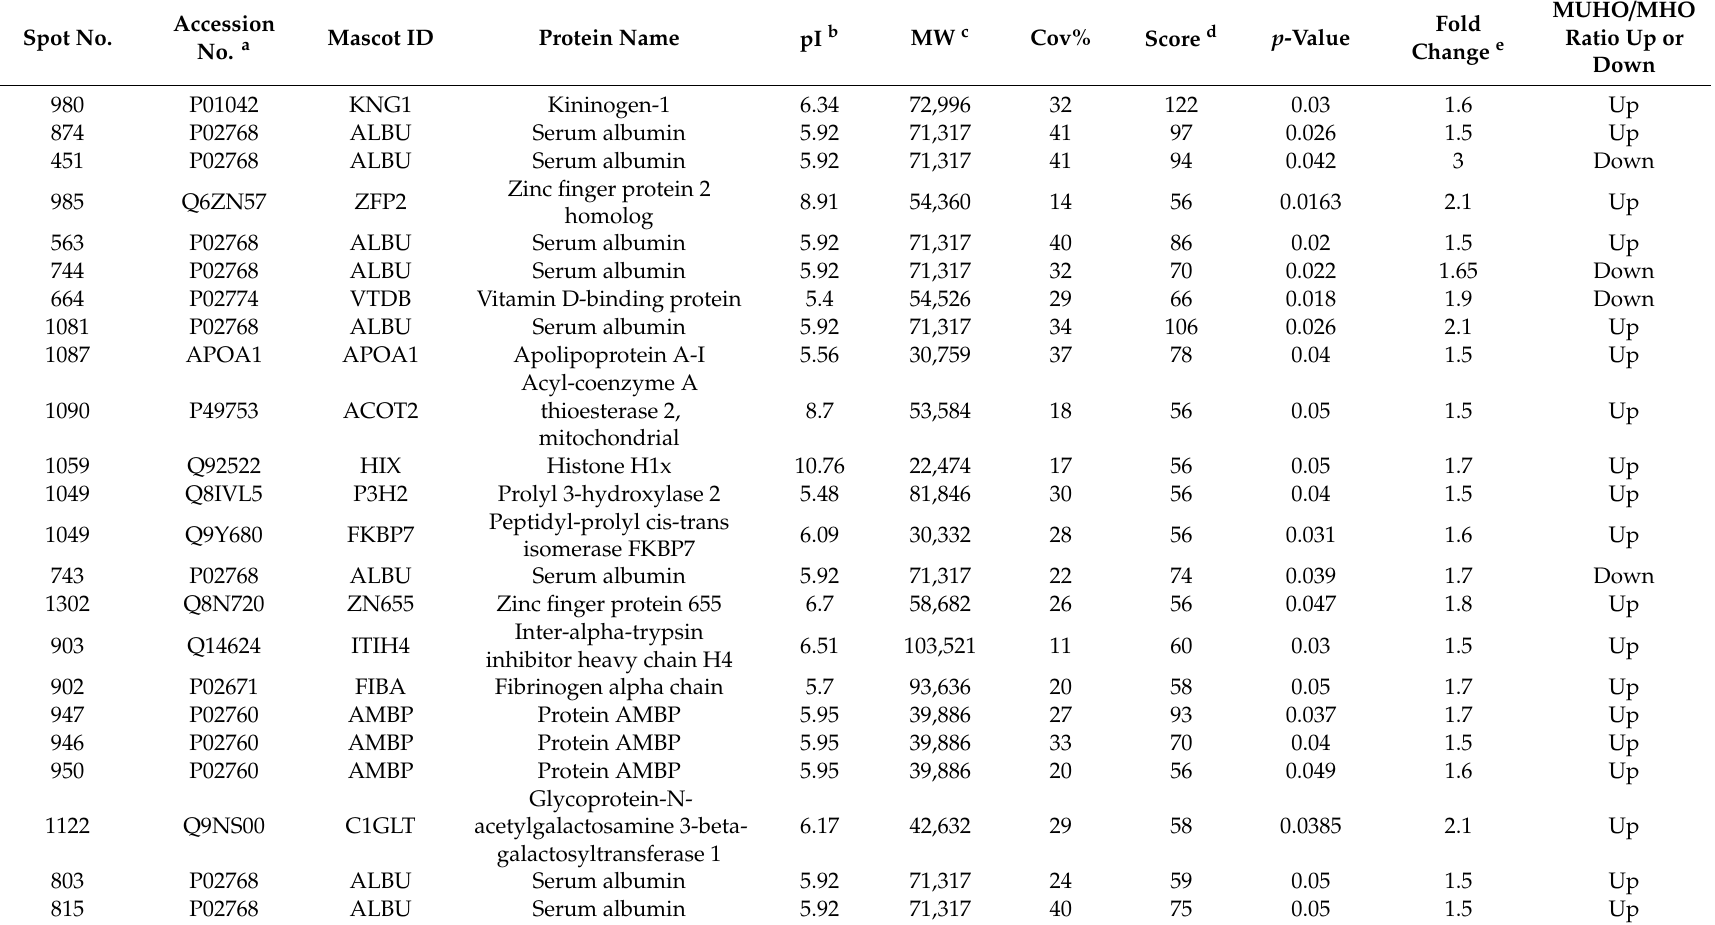
Table 2. List of di ff erentially expressed proteins identified in urine between MUHO vs. MHO groups using 2D-DIGE with di ff erences in fold change. Protein name, accession number, Mascot score, MS % coverage, MW, and pI values are listed according to the UniProt database (https: // www.uniprot.org / ).